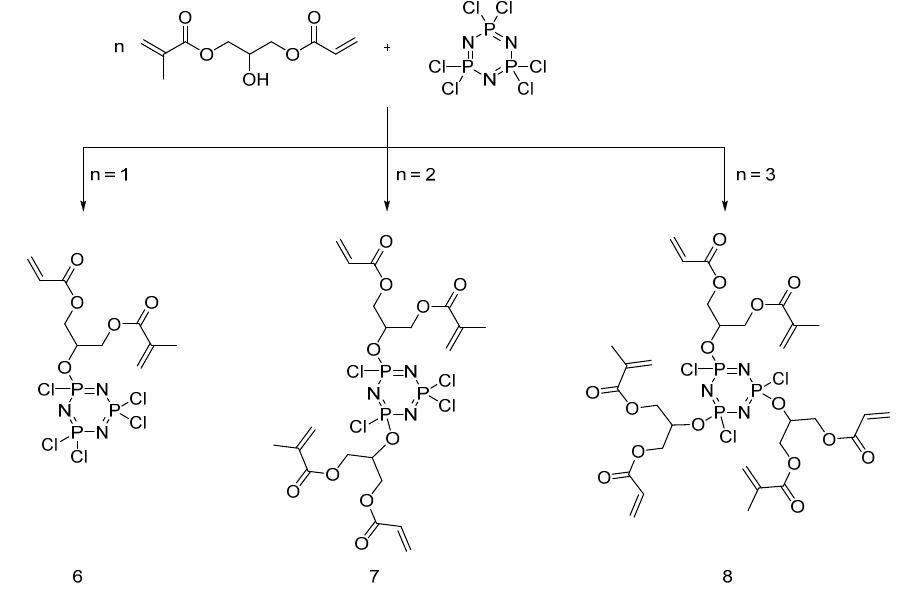
Figure 6. Representative schematic synthesis of UV-curable monomers ( 6 ), ( 7 ) and ( 8 ).